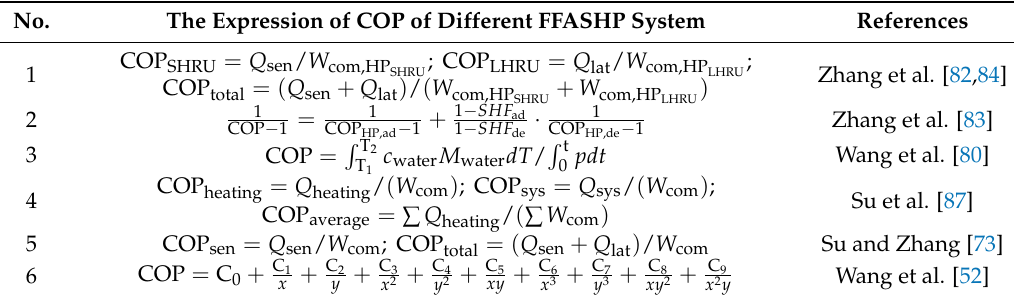
Table 13. The calculation expression of COP of various FFASHP systems.